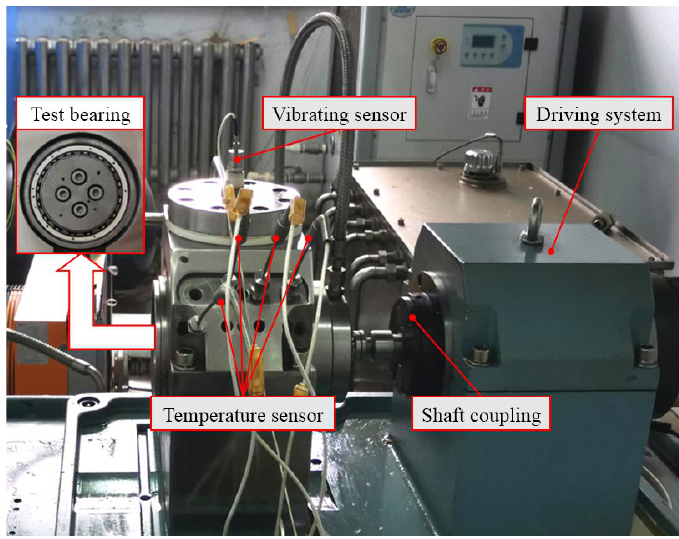
Figure 3. Main part of testing machine.